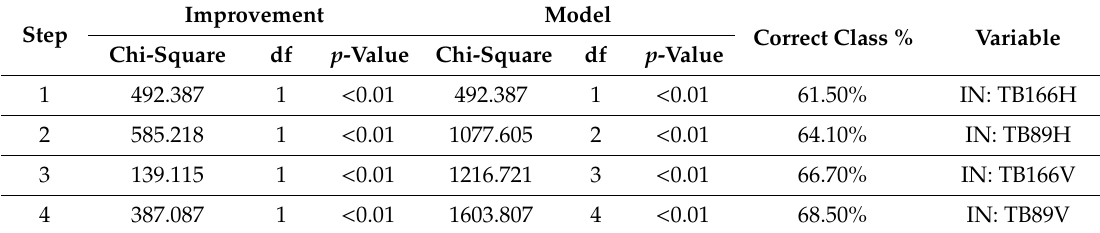
Table 5. Forward stepwise logistic regression model significance test results and performances for single channel brightness temperature measurements, vertical and horizontal polarization, at 166 GHz (TB166 V and TB166H) and 89 GHz (TB89V and TB89H) as predictors. Each step shows results from the logistic regression model with a new additional predictor variable. “df” indicates the degrees of freedom, “Chi-square” represents the observed Chi-square test statistic value, and “Correct Class” represents the correct overall classification rate.